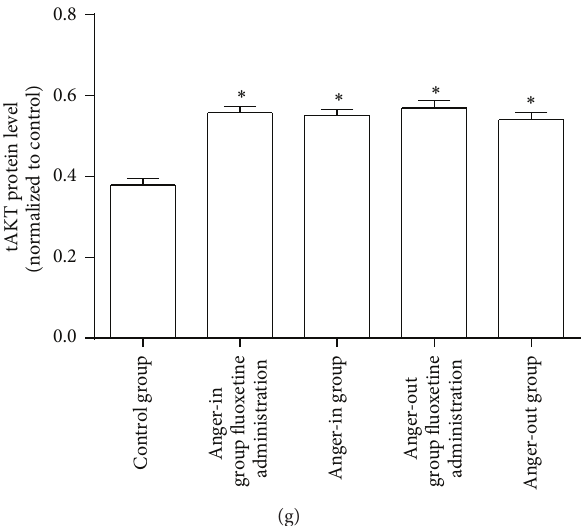
Figure 6: (a) Western blotting was performed with hippocampus’ samples of control, anger-out, anger-in, fluoxetine treated anger-out, and fluoxetine treated anger-in groups. (b) Quantitative analysis ( 𝑛 = 8 ) in pmTOR protein level ( ∗ 𝑃 < 0.05 ). (c) Quantitative analysis ( 𝑛 = 8 ) in tmTOR protein level ( ∗ 𝑃 < 0.05 ). (d) Quantitative analysis ( 𝑛 = 8 ) in pPI3Kp85 protein level ( ∗ 𝑃 < 0.05 ). (e) Quantitative analysis ( 𝑛 = 8 ) in tPI3Kp85 protein level. (f) Quantitative analysis ( 𝑛 = 8 ) in pAKT protein level ( ∗ 𝑃 < 0.05 ). (g) Quantitative analysis ( 𝑛 = 8 ) in tAKT protein level ( ∗ 𝑃 < 0.05